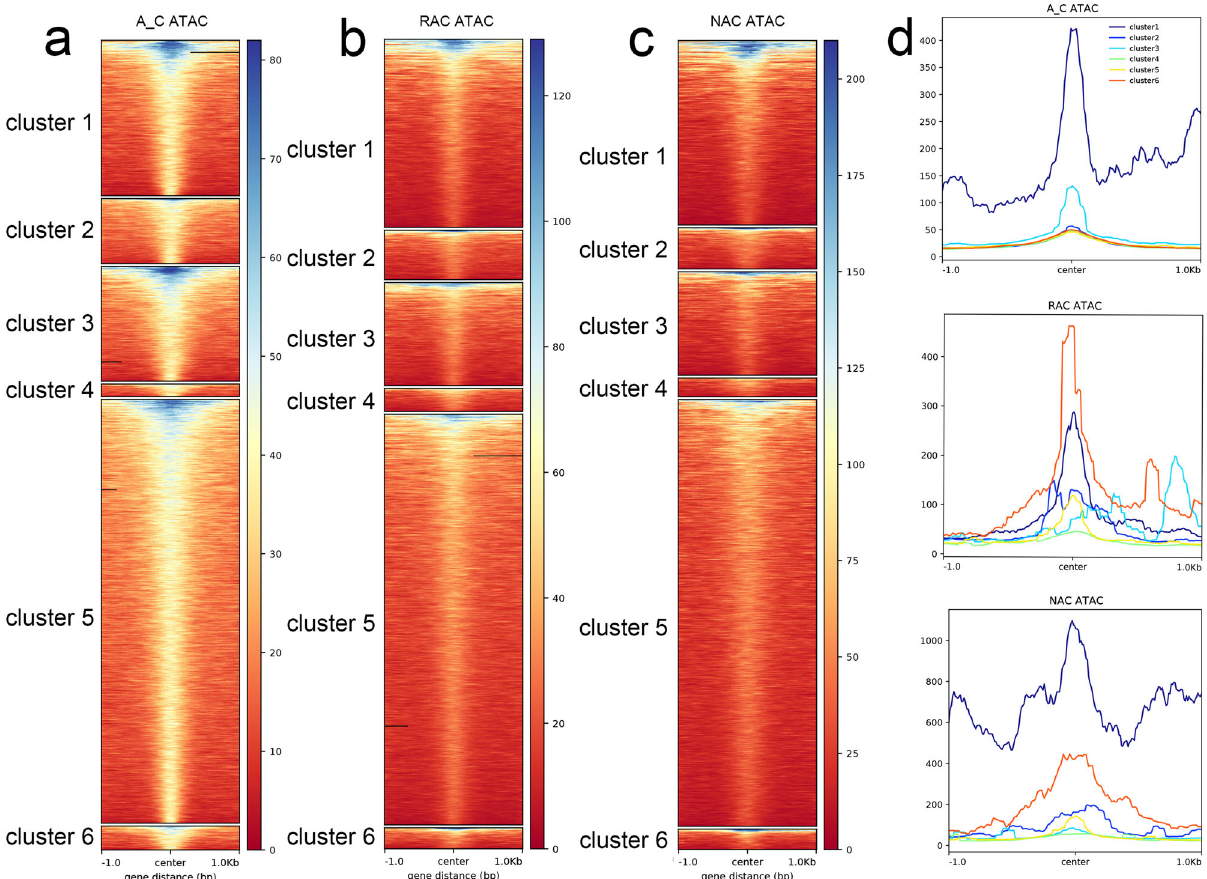
Fig. 4 Clustering analysis of histone modi fi cation-associated ACRs. a Heatmaps of 6 clusters of ACRs in the in silico ‘ hybrid ’ . a Heatmaps of 6 clusters of ACRs in the in silico ‘ hybrid ’ . b Heatmaps of 6 clusters of ACRs in resynthesized B. napus . c Heatmaps of 6 clusters of ACRs in natural B. napus . d Pro fi les of 6 clusters of ACRs in three genotypes. A_C, in silico ‘ hybrid ’ ; RAC, resynthesized B. napus ; NAC, natural B. napus ; ACRs, accessible chromatin regions; center, peak center of